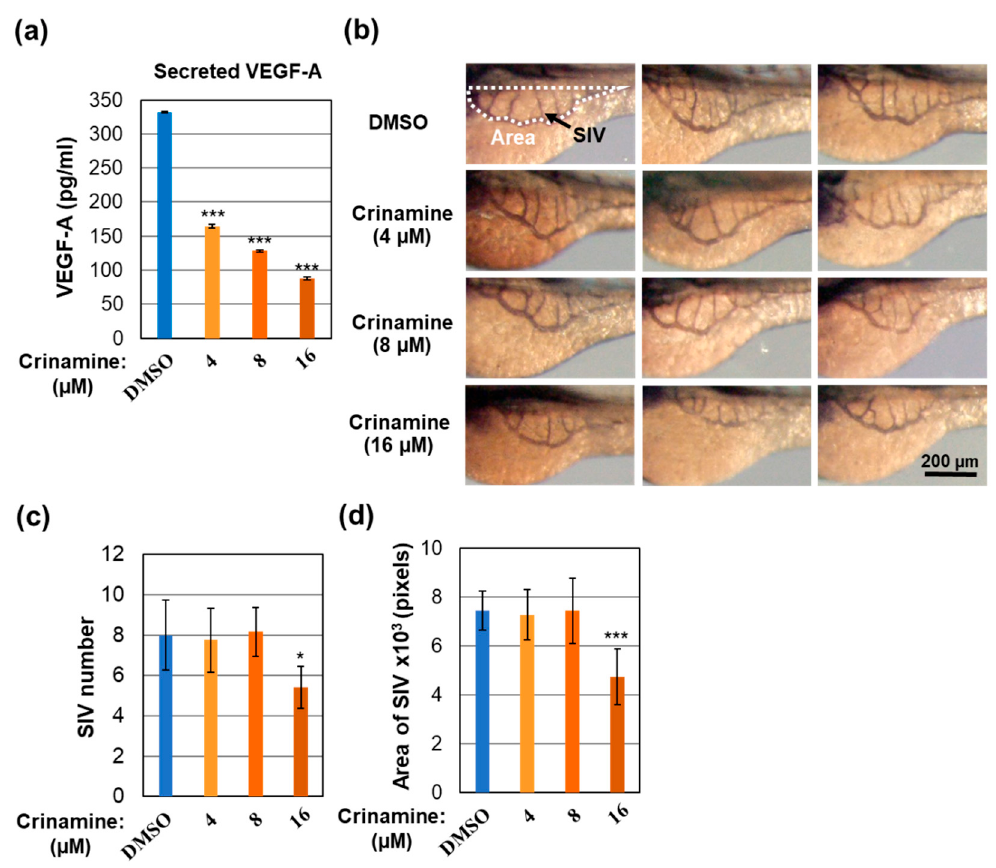
Figure 5. Crinamine-mediated inhibition of VEGF-A secretion and in vivo angiogenesis. ( a ) E ff ect of crinamine on VEGF-A release from SiHa cells. Cells were incubated for two days with the indicated concentrations of crinamine or DMSO. Secreted VEGF-A was quantified from cell culture medium by the Ella automated immunoassay platform and is reported as mean ± SD from triplicate measurements. ( b – d ) E ff ect of crinamine on SIV development in zebrafish embryos. ( b ) Representative alkaline phosphatase staining of three days post-fertilization zebrafish embryos treated with the indicated concentrations of crinamine or DMSO for three days. Images were obtained with a 3.2 × objective. ( c , d ) Quantification of the number and area of SIVs from ( b ). Data are expressed as the mean ± SD ( n = 12 per group). * p < 0.05; *** p < 0.001.